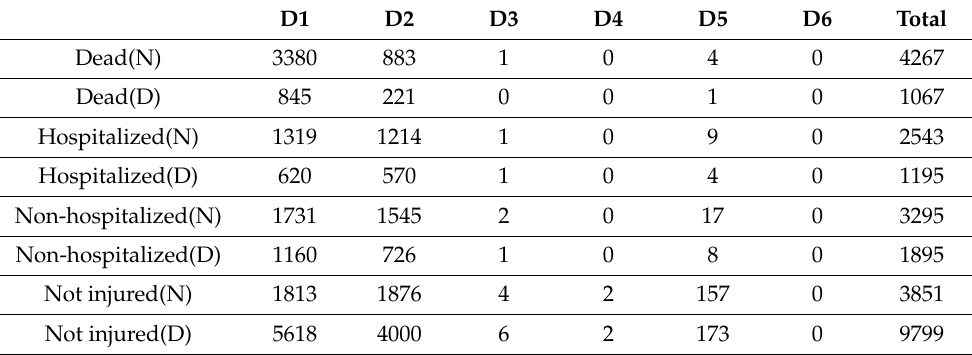
Table 15. Number of casualties in the 1721 earthquake in District 6 of Tabriz.